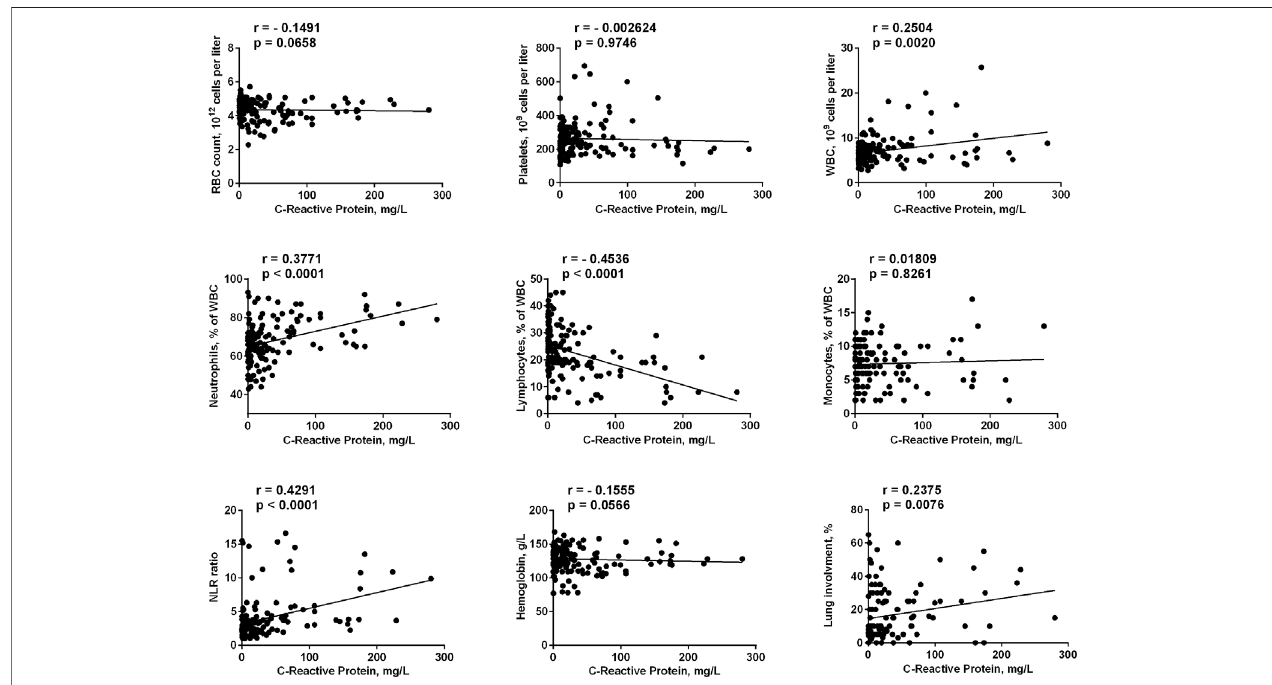
FIGURE2| CorrelationofmainbloodandbiochemicalparameterstakenonadmissiontothehospitalwithC-reactiveprotein.Thedataonday1forFMNgroupand days 1 and 7 for control group were used.